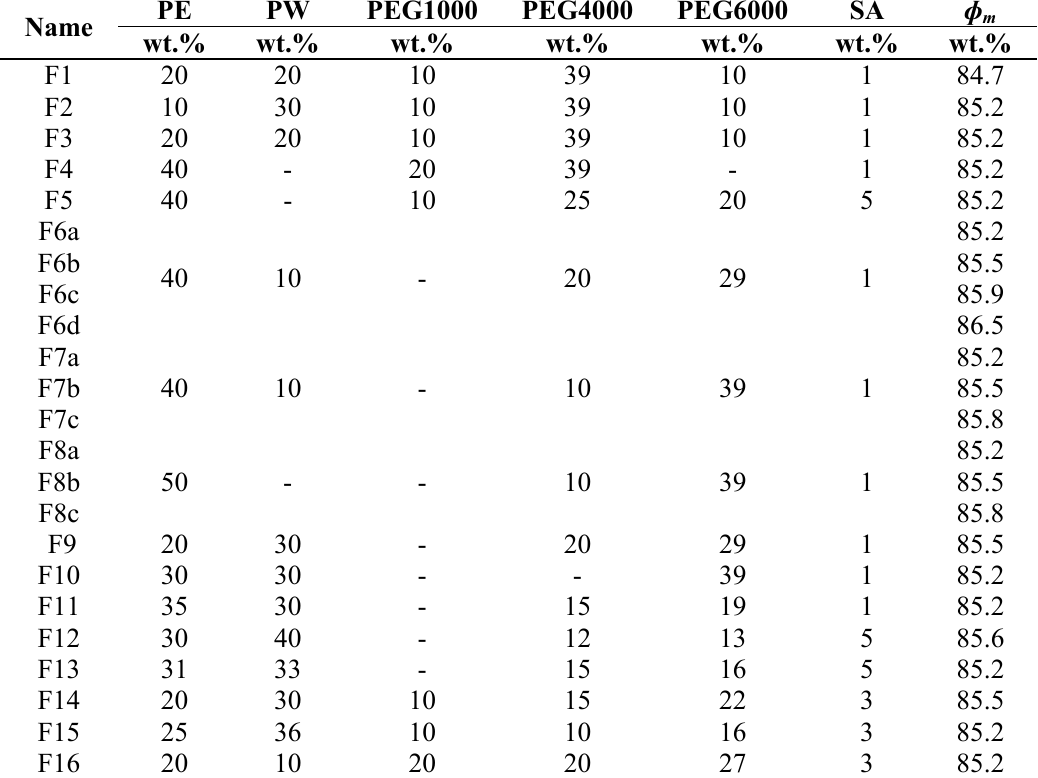
Table 1. Polyolefin-based